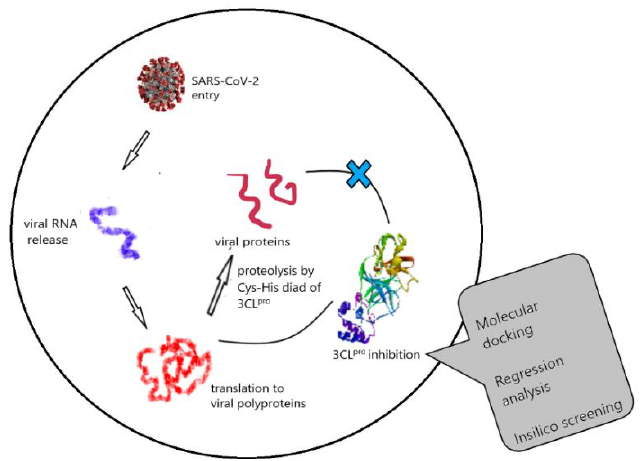
Figure 12. Design of inhibitors of main protease using in silico tools.